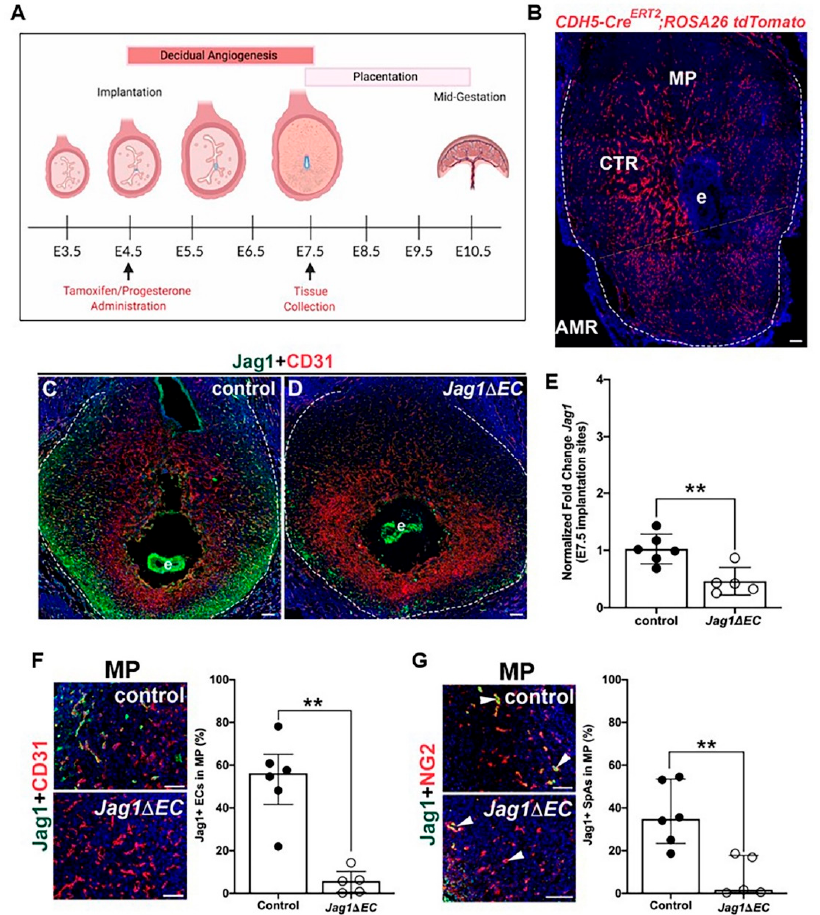
Figure 4. Tamoxifen-induced Cre recombination decreases expression of Jag1 in Cdh5-Cre ERT2 ;Jag1 flox / flox ( Jag1 Δ EC ) pregnancy. ( A ) Schematic of the mouse gestation timeline highlighting key processes involved, and experimental timeline (created with BioRender.com). At E4.5, tamoxifen is administered to induce Cre recombination and progesterone was administered to minimize secondary angiogenic defects in the uterus due to vascular defects in the ovaries. Pregnancies and uterine phenotype were assessed at E7.5. ( B ) Representative image of an implantation site at E7.5 from the Cdh5-Cre ERT2 ; ROSA26 tdTomato reporter. The decidua is within the dashed white. tdTomato expression, indicating Cre-induced recombination, is detected in a vascular pattern throughout the decidua. Dashed line denotes MR and AMR. ( C , D ) Representative images of implantation sites of Cdh5-Cre ERT2 control and Jag1 Δ EC pregnancies stained for Jag1 and CD31. Expression of Jag1 is reduced in the decidua (outlined with dashed white lines), but not the embryo of Jag1 Δ EC mutants. ( E ) qRT-PCR determination of Jag1 expression in implantation sites from control ( n = 6) and Jag1 Δ EC ( n = 5) pregnancies. The relative expression level of Jag1 was compared to β -actin. Jag1 was significantly decreased in Jag1 Δ EC mutants as compared to Cdh5-Cre ERT2 controls. ( F ) Representative images of the MP of control and Jag1 Δ EC implantation sites double stained for EC marker CD31 and Jag1. At the MP, expression of Jag1 in all CD31 + ECs is reduced in Jag1 Δ EC mutants ( n = 6) as compared to Cdh5-Cre ERT2 controls ( n = 5). ( G ) Representative images of the MP of control and Jag1 ∆ EC implantation sites double stained for